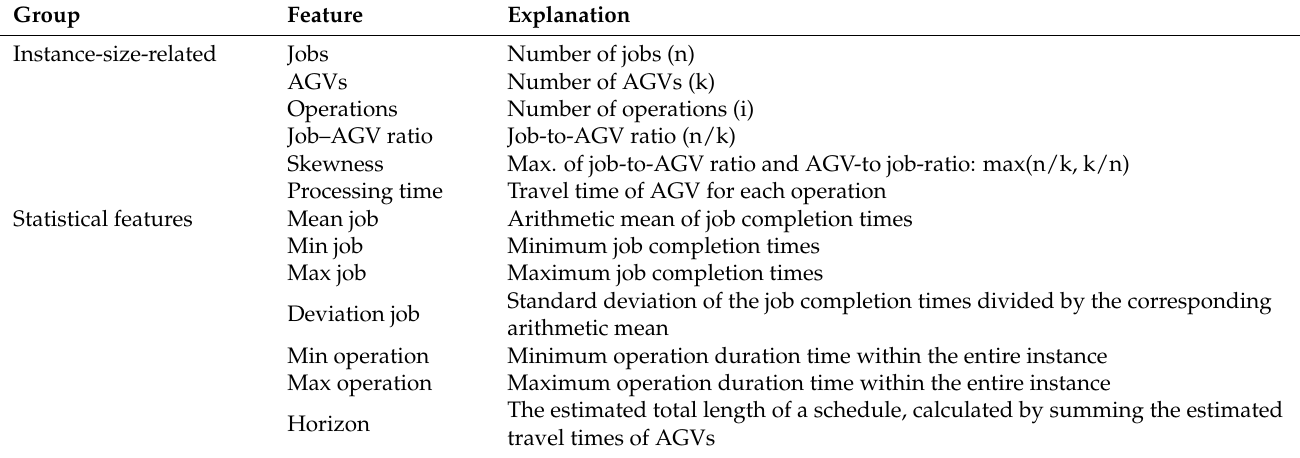
Table 3. Feature description for scheduling problem